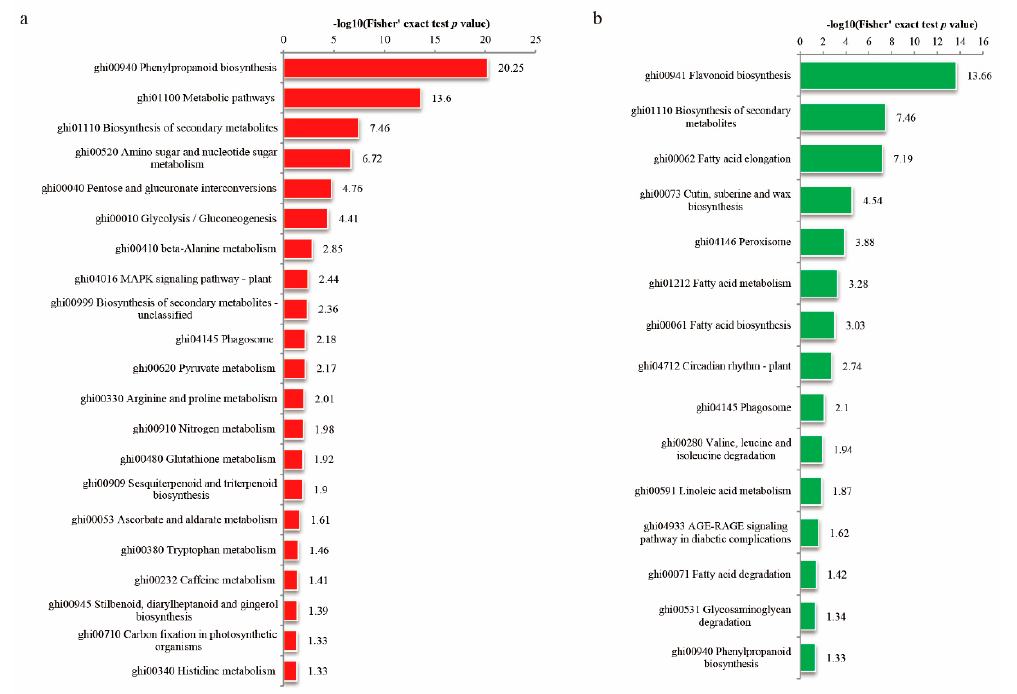
Figure 5. KEGG enrichment analysis of cotton fibers and ovules treated by FB1 and the control. ( a ) Up-regulated proteins (red bars); ( b ) down-regulated proteins (green bars).